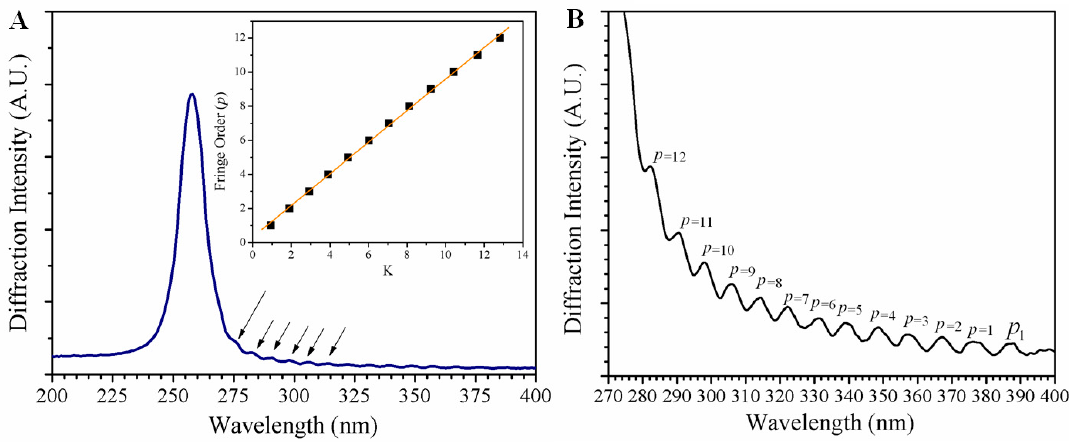
Figure 4. ( A ) Diffraction spectra of PMMA assembled crystal, and the evident FP fringes are labeled by arrows (Inset: FP fringe plot); ( B ) An enlarged view of the FP interference fringes.